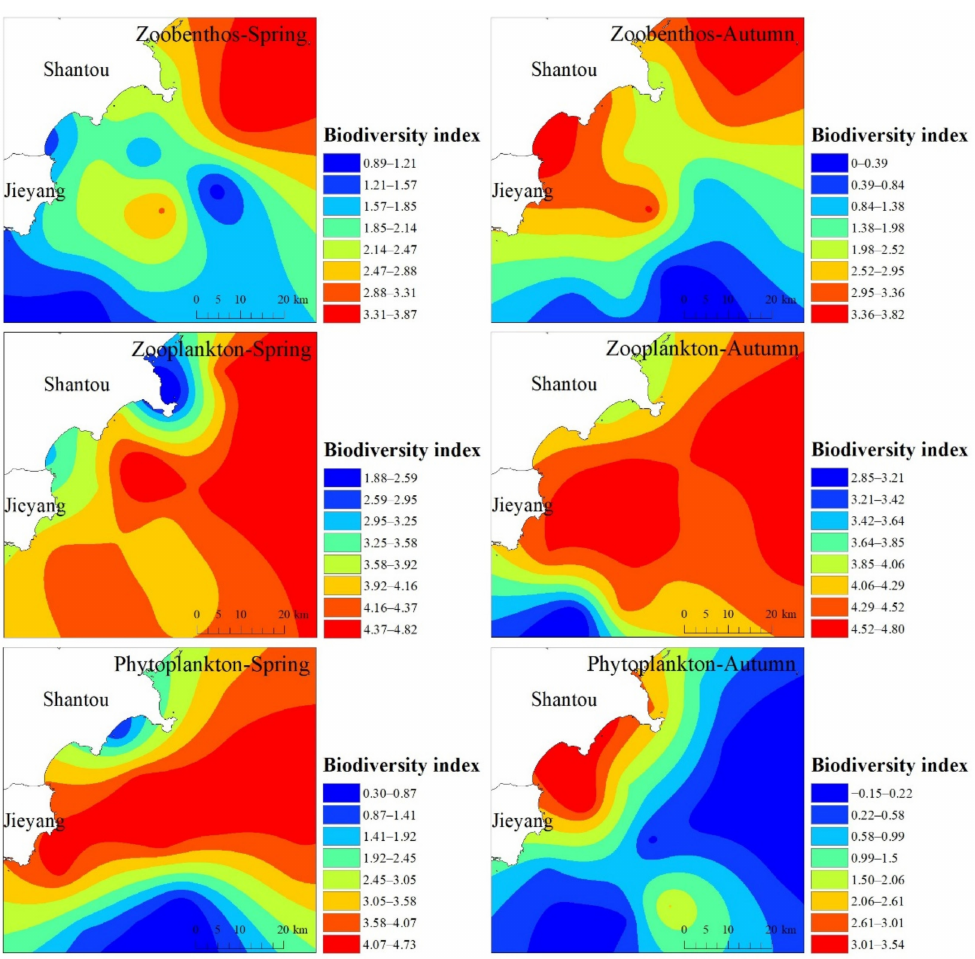
Figure 4. Evaluation results of species diversity index on the coast of Hong